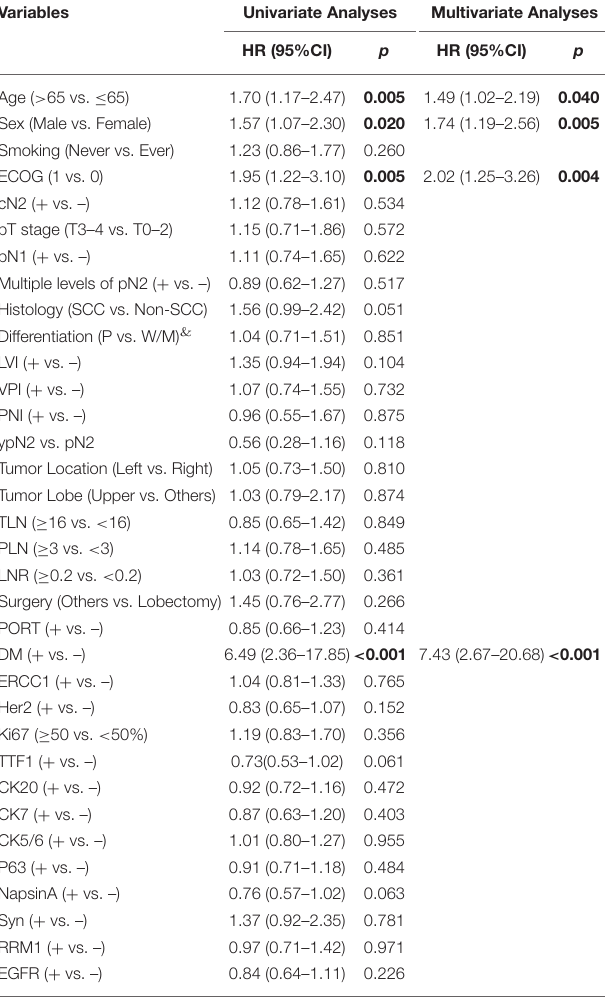
TABLE 3 | Cox analyses of clinical-pathological variables associated with overall survival (OS1). Variables